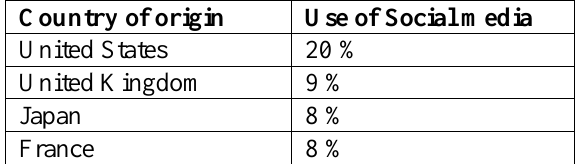
Table 6: Companies’ Country of Origin Where Social Channels Are Most Used